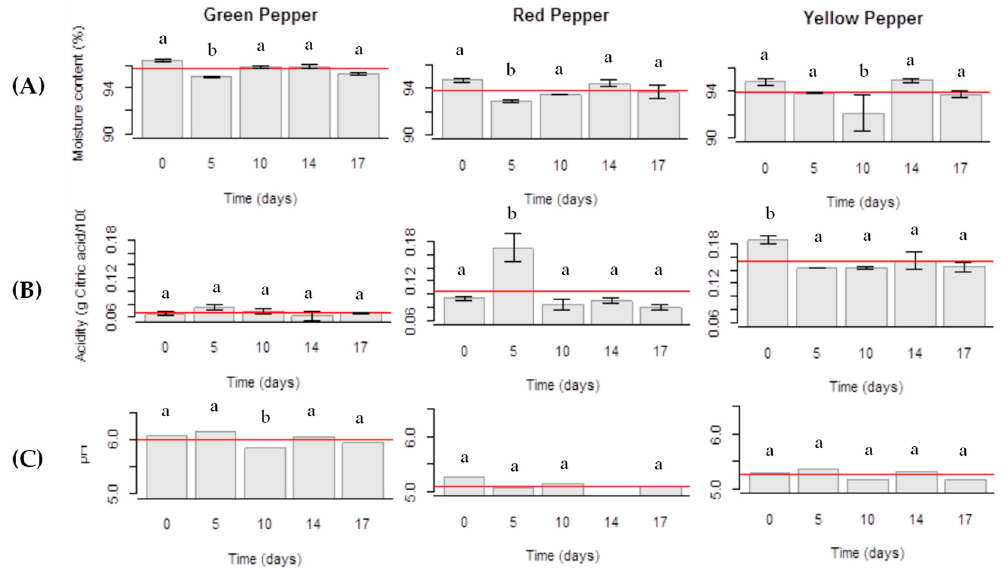
Figure 2. ( A ) Moisture content, ( B ) titratable acidity and ( C ) pH values of fresh-cut bell peppers